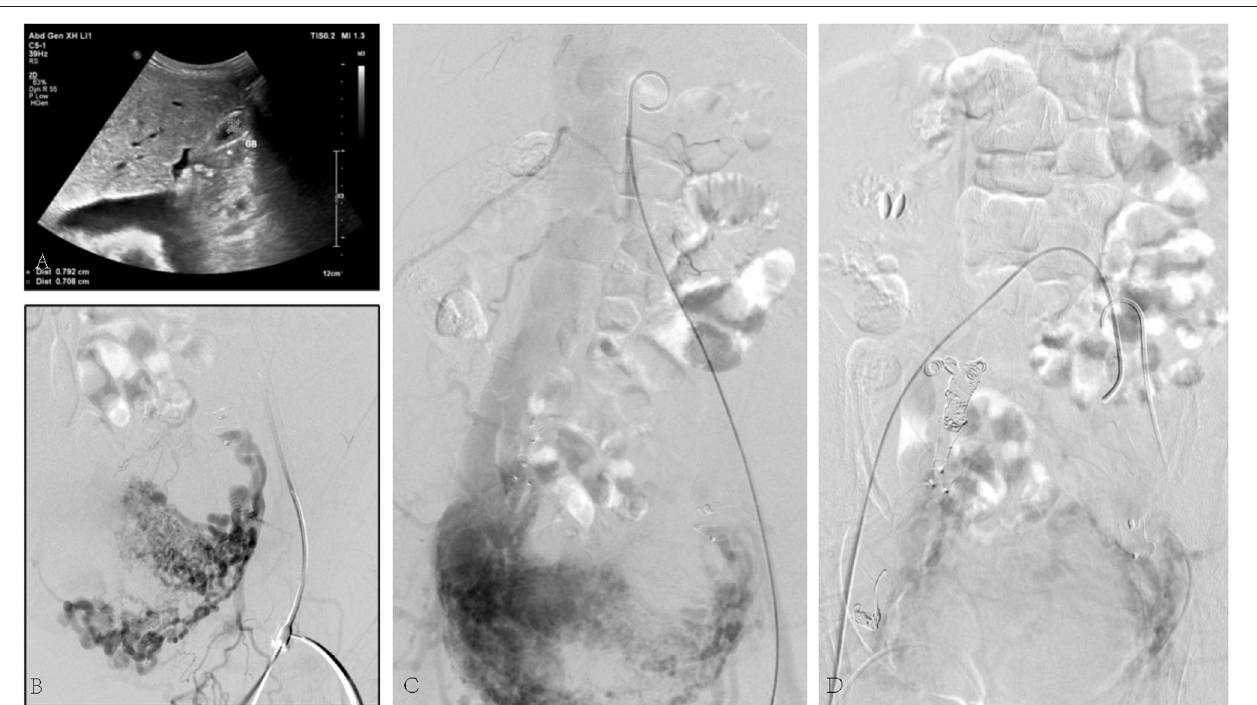
FIGURE 4 | (A) Tumor enhanced in the arterial phase. (B) Ultrasound revealing tumor being extracted during surgery. (C) Tumor being pulled out from the IVC.